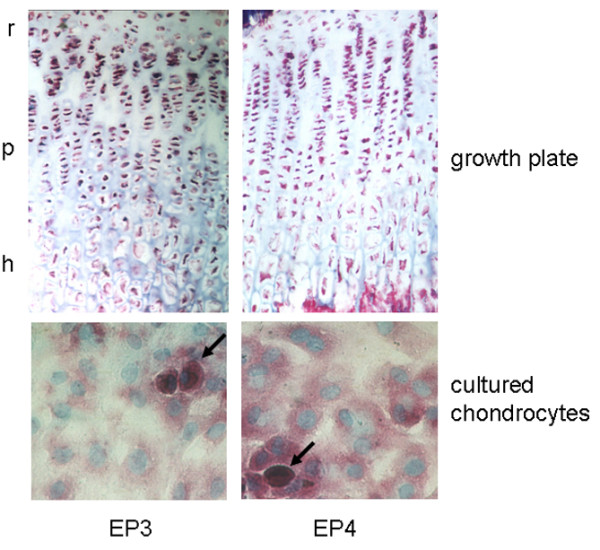
Immunohistochemical detection of EP3 and EP4 receptor proteins in rat growth plates and in cultured chondrocytes. Protein expression of EP3 and EP4 receptor was studied in growth plate tissue and cultured chondrocytes using isoform-specific antibodies. The EP3 and EP4 receptors were distributed throughout the whole growth plate. Cultured chondrocytes exhibited only weak reactivity towards the anti-EP antibodies. Only a minor subpopulation of cells showed strong staining for EP3 receptor and EP4 receptor. Magnification: 200 × . r, reserve zone; p, proliferative zone; h, hypertrophic zone.